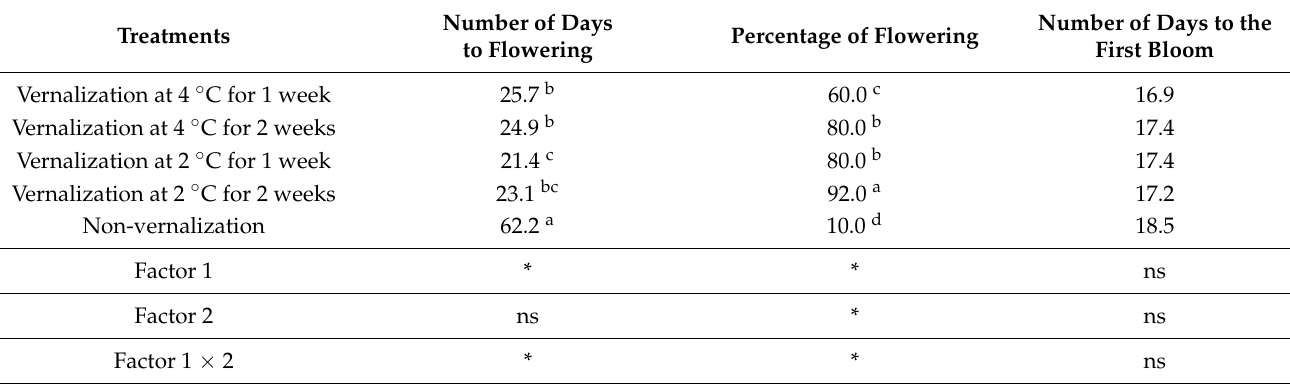
Table 2. Effects of vernalization on number of days to flowering, percentage of flowering and number of days to the first bloom in strawberry cv. Pharachatan 80.